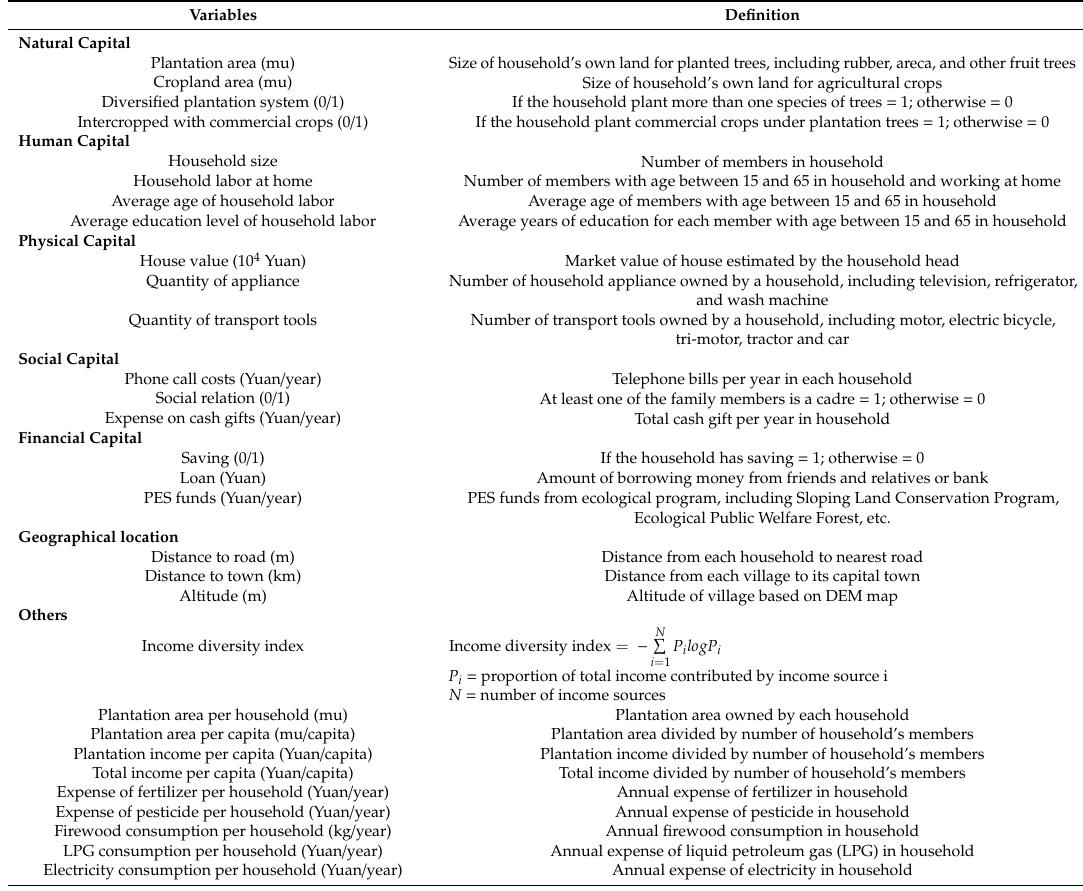
Table A1. The definition of explanatory